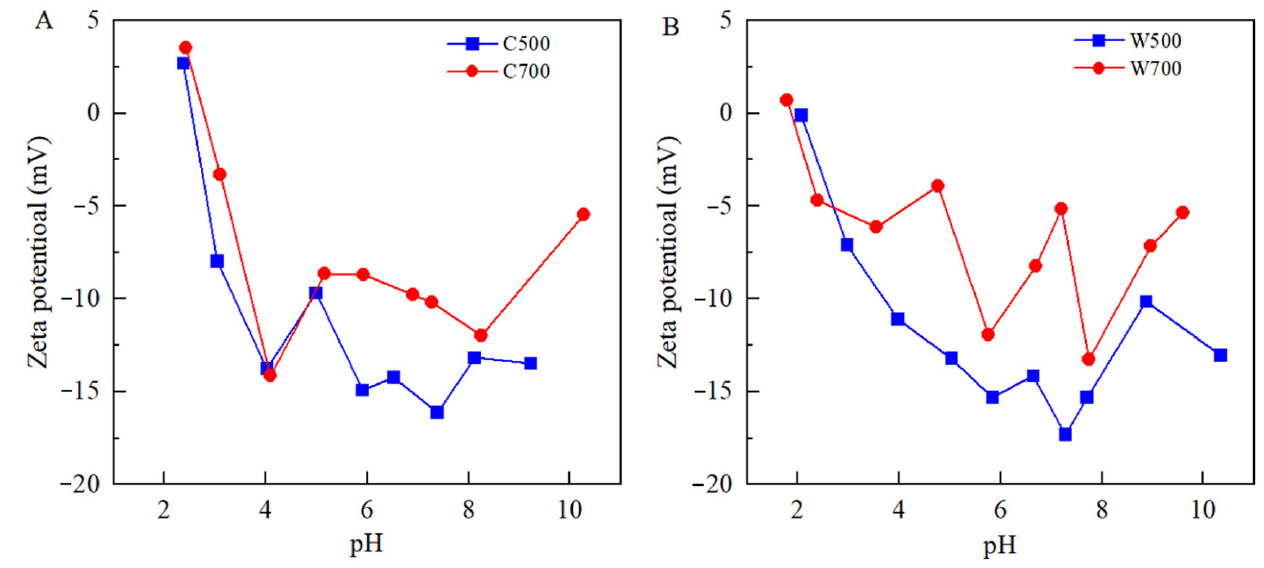
Figure 2. Zeta potential of corn biochars ( A ) and wheat biochars ( B ).